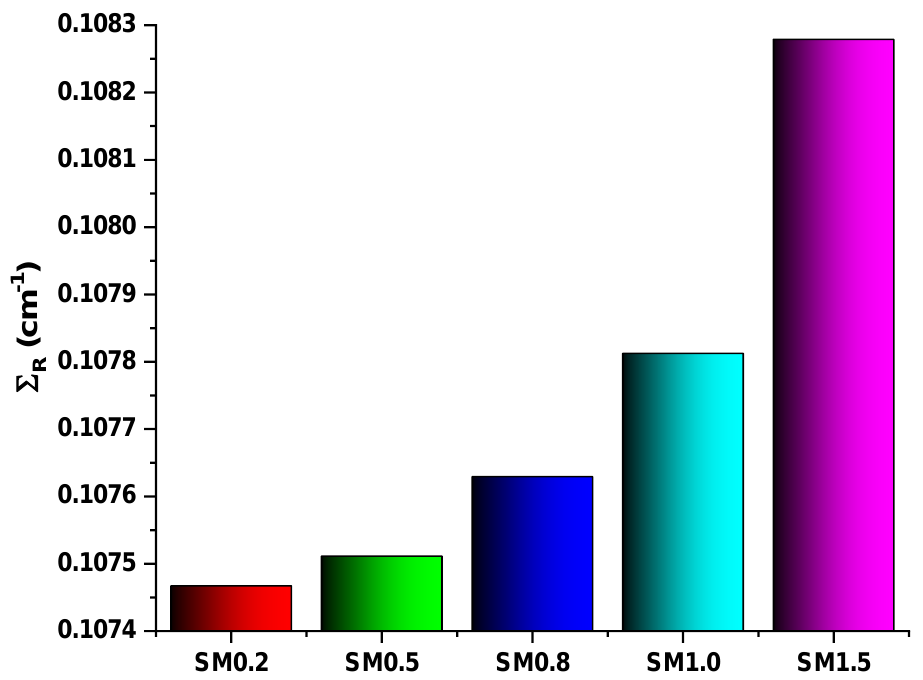
Figure 11. Effective removal cross-sections for fast neutrons ( Σ R ) for all glasses.